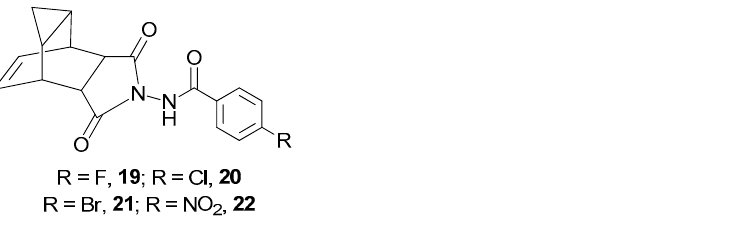
Figure 5. Tecovirimat derivatives 19 – 22 with aromatic substituent, contained in 13a , b – 15a , b, 18a , b .